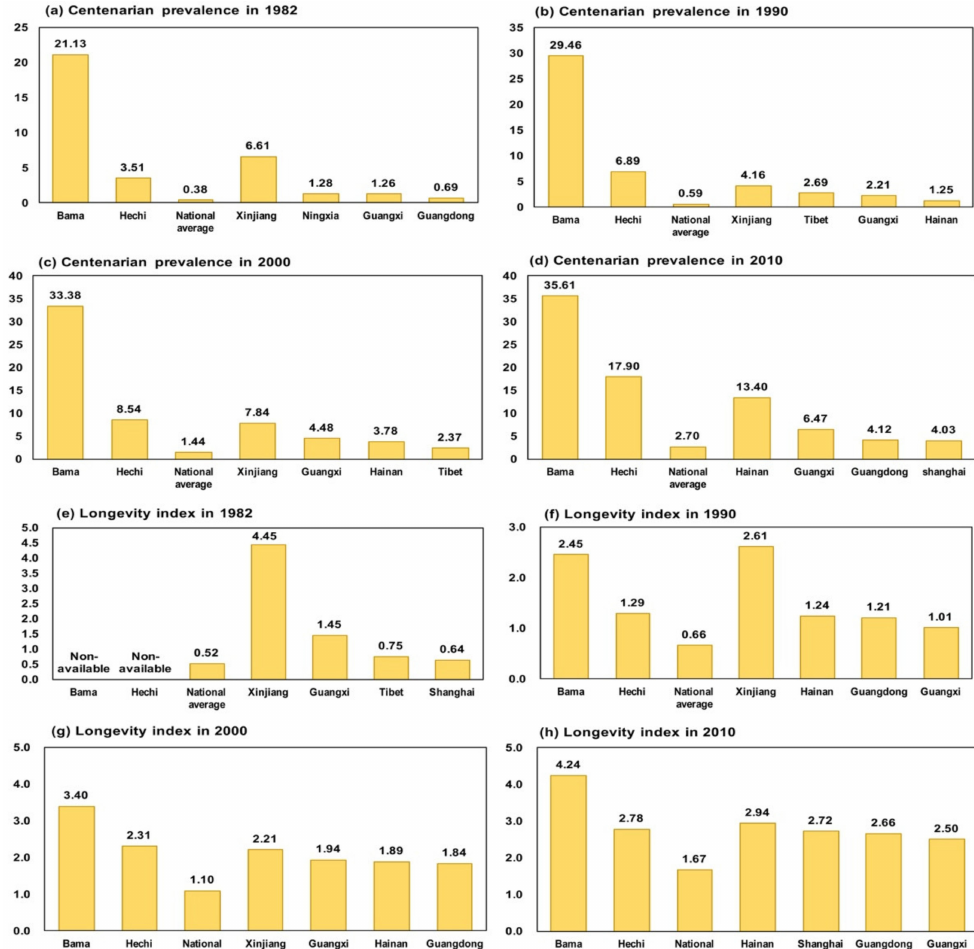
Figure 2. Comparison of the centenarian prevalence in Hechi, Bama and the other top four provinces in China in 1982 ( a ), 1990 ( b ), 2000 ( c ) and 2010 ( d ) and comparison of the longevity index in Guangxi, Hechi, Bama and the other top four provinces in China in 1982 ( e ), 1990 ( f ), 2000 ( g ) and 2010 ( h ). (Data for the national average and top four provinces were obtained from Wang et al., 2015